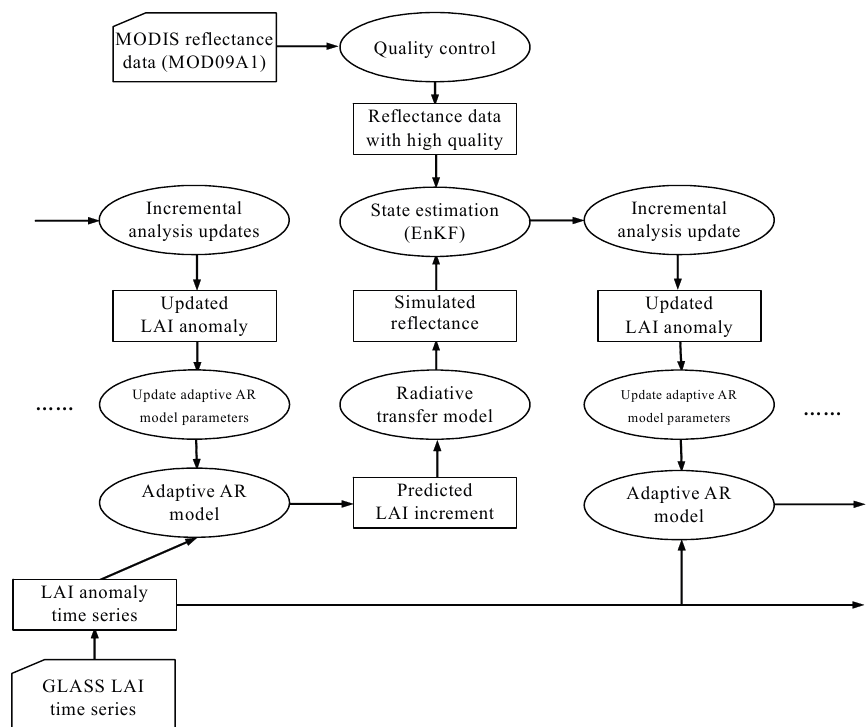
Figure 1. Flow chart of the LAI inversion method with incremental analysis updates. AR, autoregressive; ensemble Kalman filter (EnKF), ensemble Kalman